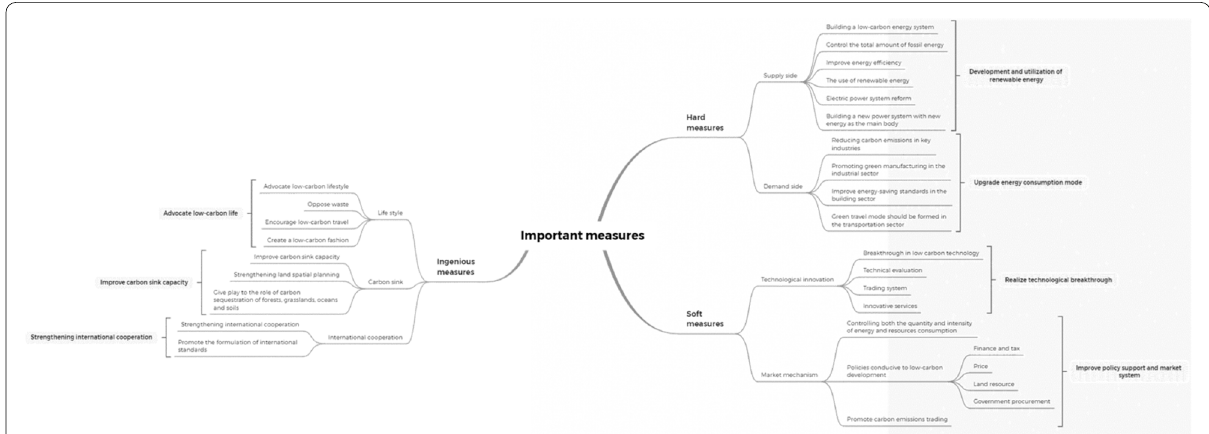
Fig. 15 Important measures to decarbonize the building sector from buildings/communities to